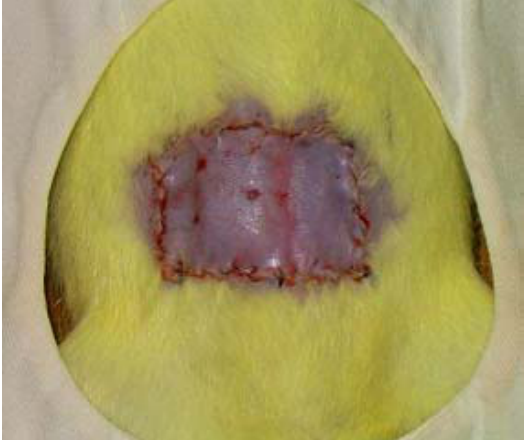
FIGURE 8: Sutura of flap skin in its original position, also using monofilamentar